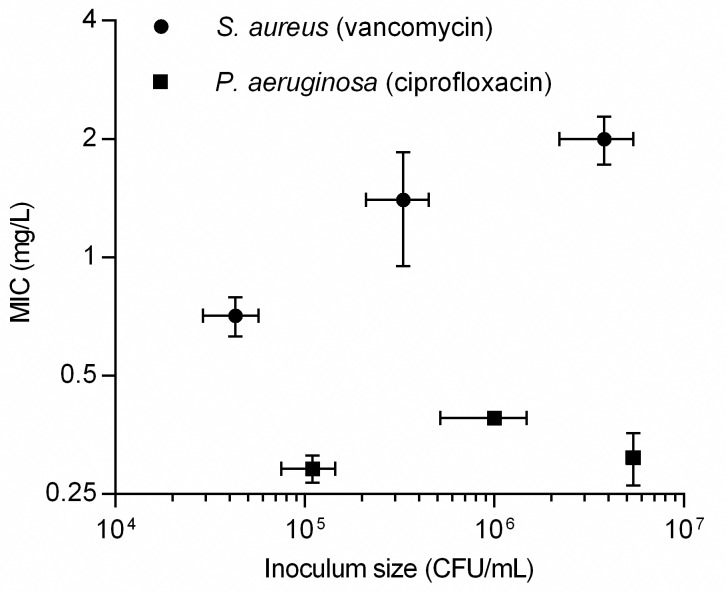
MIC values of VSSA and P. aeruginosa at different inocula.To determine the lower detection threshold and optimal bacterial concentrations in CellDirector 3D, a range of 103 to 106 CFU/mL for S. aureus (VSSA) and P. aeruginosa was tested against vancomycin and ciprofloxacin, respectively (for inocula <104 CFU/mL no MIC could be determined). Circles—VSSA and vancomycin, squares—P. aeruginosa and ciprofloxacin, error bars signify standard deviation.